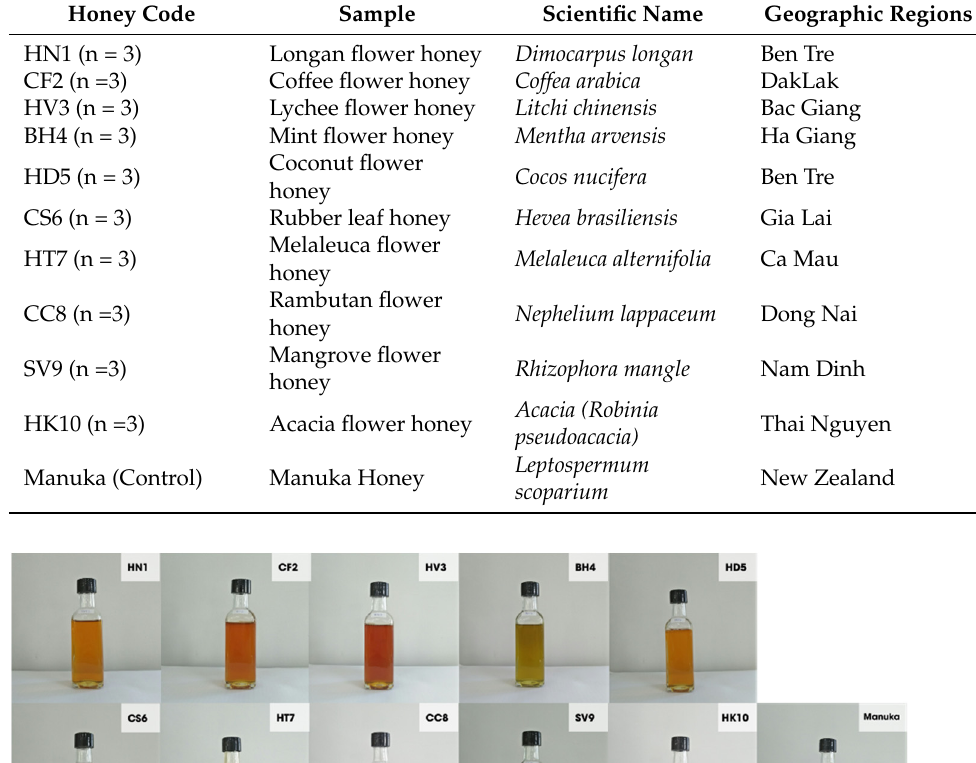
Table 1. Classification of honey types and regional sources.